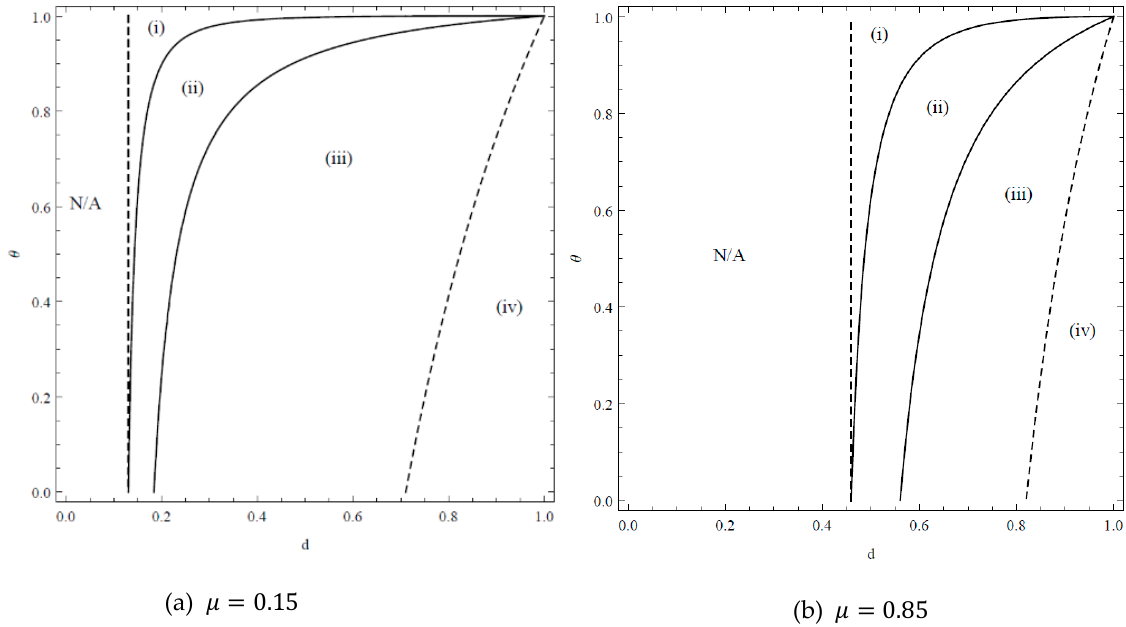
(a) (cid:2020) = 0.15 (b) (cid:2020) = 0.85 Figure 5. Equilibrium Outcome in the Presence of Reference Price Effects. ( d is the publisher’s wholesale discount rate of the printed book; θ is consumers’ acceptance level of an e-book; µ is the degree of consumers’ concern about a discount; (i), (ii), (iii) and (iv) represent cases (i), (ii), (iii) and (iv) in Lemma 2, respectively; N/A represents the case (v) in Lemma 2).